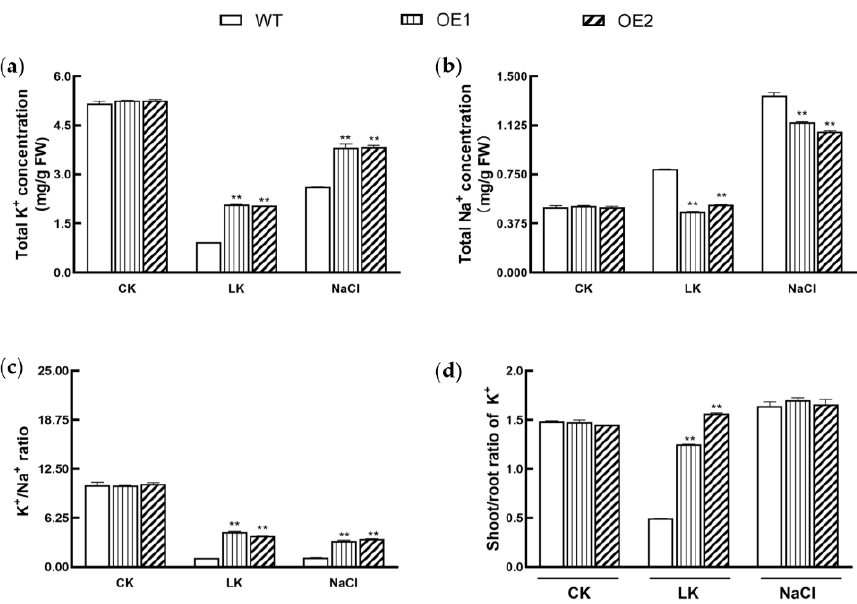
Figure 7. Measurement of K + and Na + in transgenic and WT plants under normal, low-K + and high-salinity conditions. ( a ) K + and ( b ) Na + concentration of the whole plantlets. ( c ) K + /Na + ratio of the whole plants. ( d ) Shoot/root ratio of K + . Data are presented as means ± SE ( n = 3). ** indicates a significant difference at p < 0.01 between WT and transgenic lines.